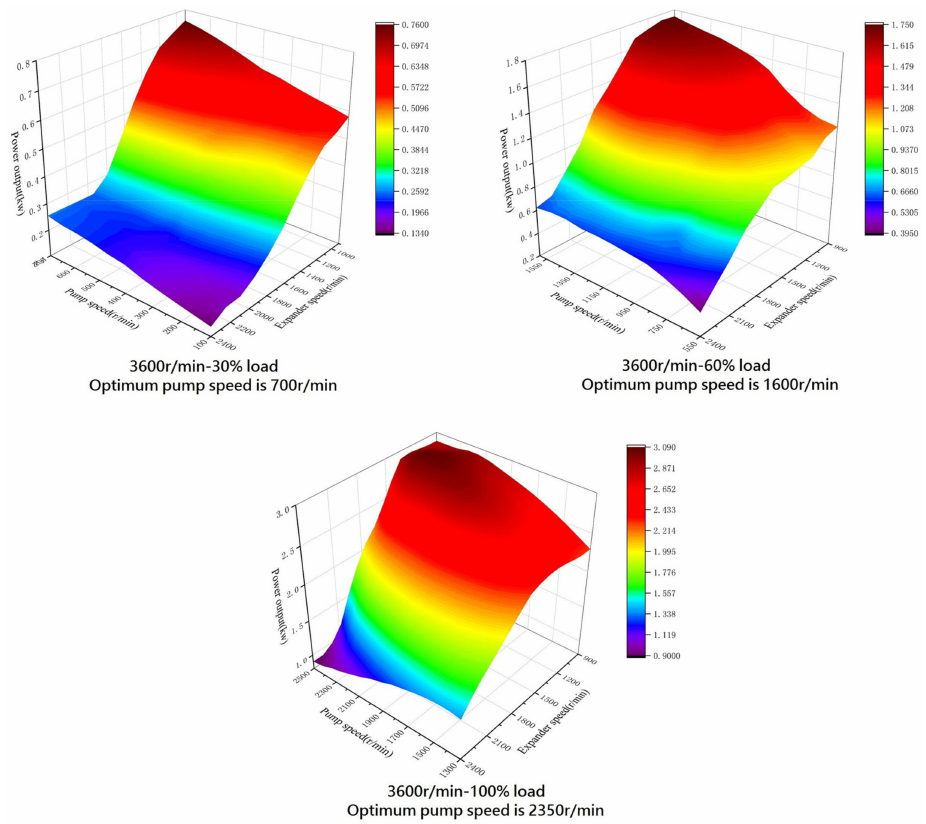
Figure 9. Results for the net power of the ORC under various engine loads with an engine speed of 3600 r / min.